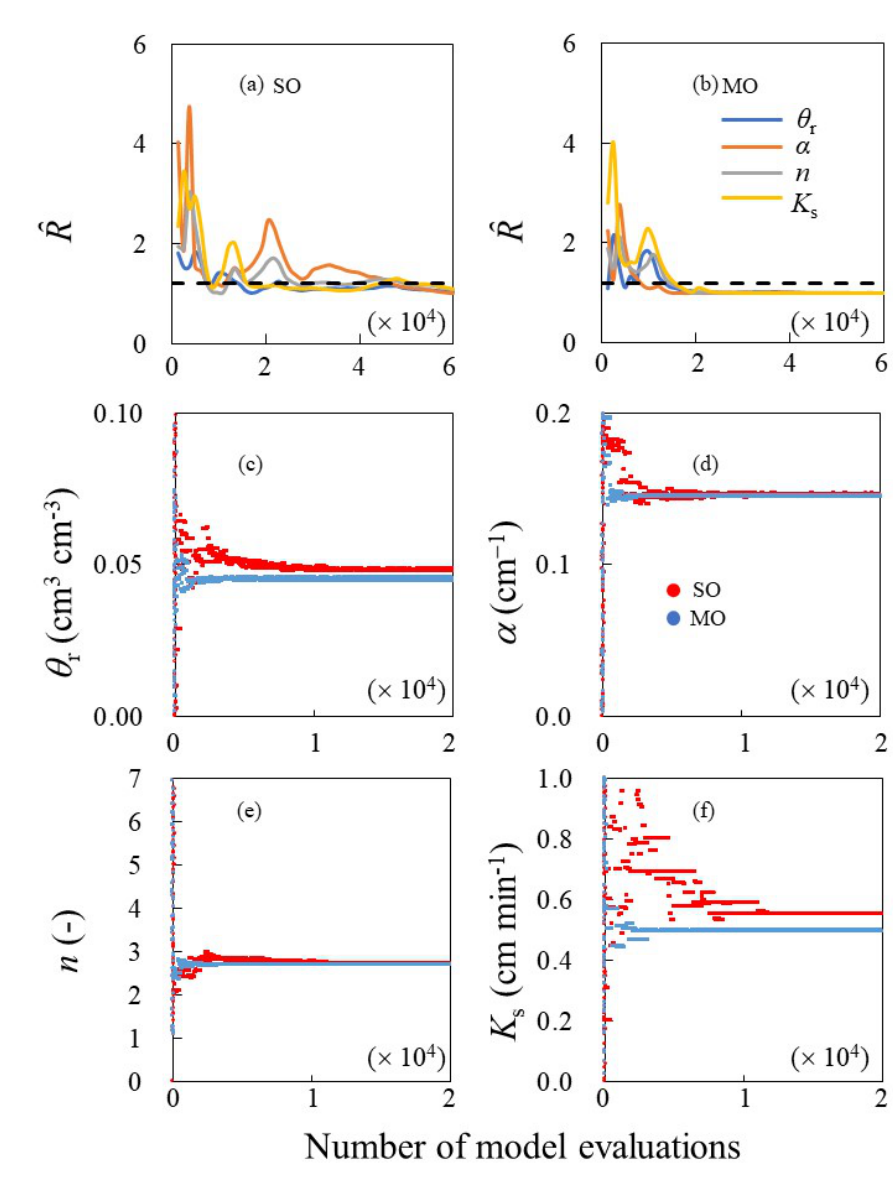
Figure 2. Trace plots of inverse modeling for the sand example: ( a ) the “ R -statistic with the SO approach; ( b ) the “ R -statistic with the MO approach; and ( c – f ) are mixed changes in parameter values with evaluations along three Markov